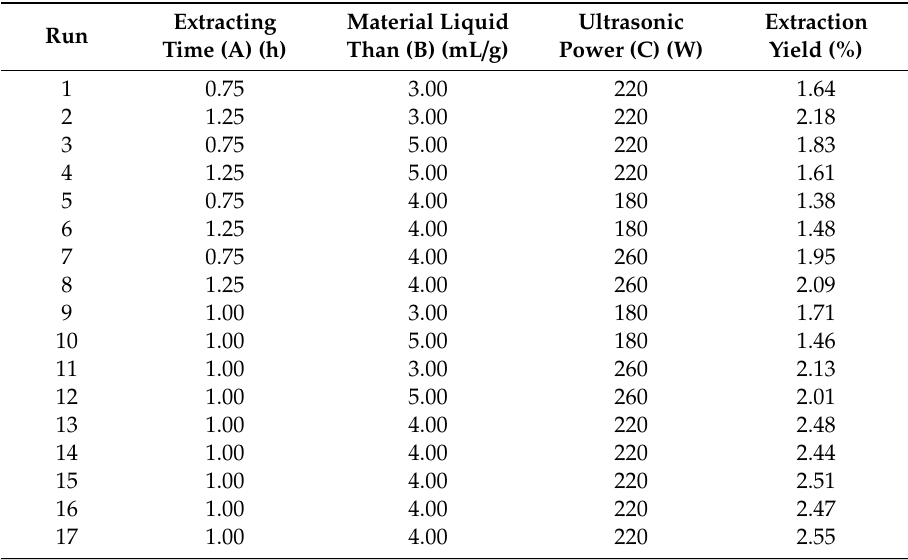
Table 2. Box–Behnken experimental design and results for extraction yield. Extracting Material Liquid Run Time (A) (h) Than (B) (mL /